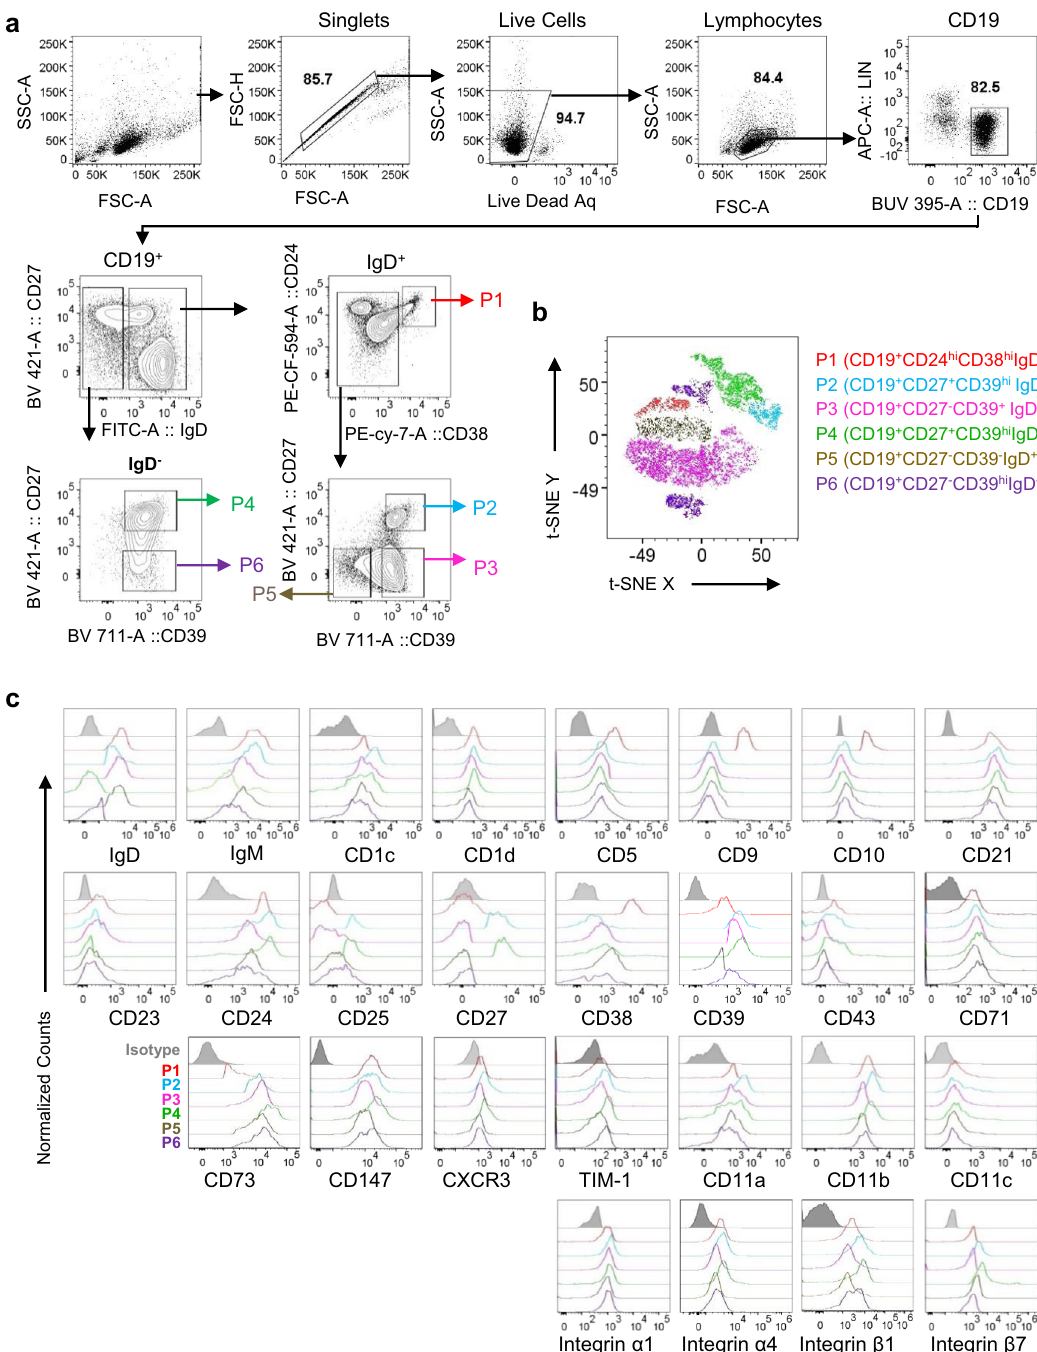
Fig. 2 Human peripheral blood B cells are composed of six different populations. a B cells subsets P1 (CD19 + CD24 hi CD38 hi IgD + ), P2 (CD19 + CD27 + CD39 hi IgD + ), P3 (CD19 + CD27 − CD39 + IgD + ), P4 (CD19 + CD27 + CD39 hi IgD − ), P5 (CD19 + CD27 − CD39 − IgD + ), and P6 (CD19 + CD27 − CD39 + IgD − ) B cells in the blood of healthy subjects. Data generated with cells from healthy subjects ( n = 5) were combined. b A t -SNE plot, showing the distribution of the six B cell populations (P1 to P6). t- SNE plots were made on CD19 + B cells using cell surface markers, including IgD, CD24, CD27, CD38, CD39, with iteration 1000, perplexity 30, and learning rate (eta) 1564. c Cell surface expression of IgD, IgM, CD1c, CD1d, CD5, CD9, CD10, CD21, CD23, CD24, CD25, CD27, CD38, CD39, CD43, CCD71, CD73, CD147, CXCR3, TIM-1, CD11a, CD11b, CD11c, integrin α 1, integrin α 4, integrin β 1, and integrin β 7 on P1 (red), P2 (light blue), P3 (pink), P4 (light green), P5 (army green), and P6 (violet) B cells. Data generated with cells from healthy subjects ( n = 5) were